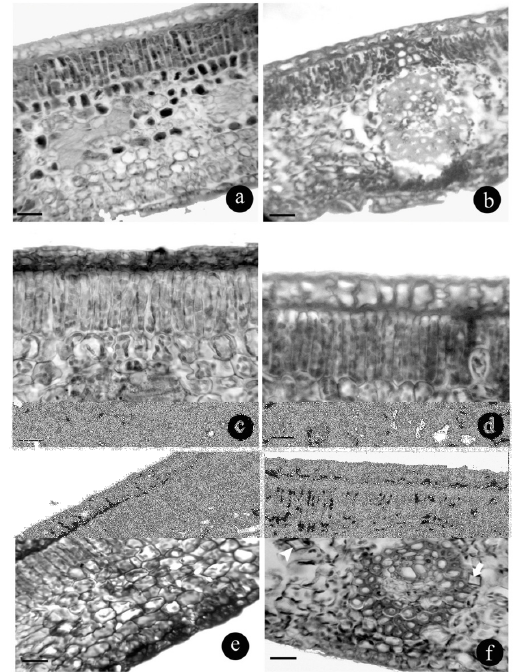
Fig. 2. Anatomical features of the leaf lamina in M. indica, magnification bar, a to f –10 mm a. ‘Jamadar’- 3' layers of pallisade with cells of different size, spongy layer cells compactly arranged; b. ‘Mulgoa’- single layered pallisade, spongy layer loosely arranged; c. ‘Rucchado’- single layered pallisade, spongy layer compactly arranged; d. ‘Ladvo’- single layered pallisade, spongy layer compactly arranged; e. ‘Khodi’- single layered pallisade, spongy layer compactly arranged; f. ‘Kesar’- single pallisade, spongy layer loosely arranged, crystal at the periphery of vascular bundle (arrow) and in spondy layer cells (arrowhead)